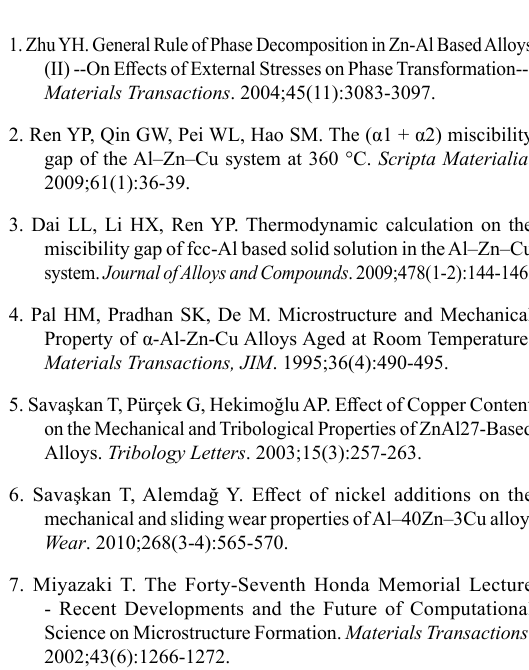
Figure 9. Al, Cu and Zn concentration profiles of the Al-20at.%Zn- 5at.%Cu aged at 450 °C for different times.